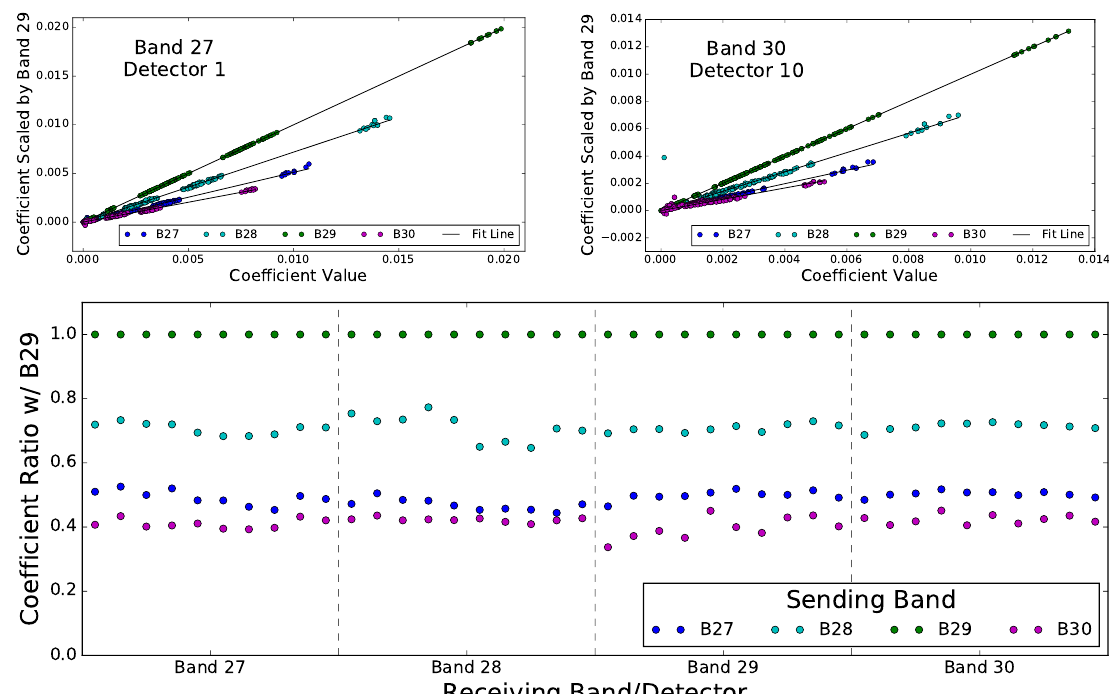
Figure 5. Comparison of the correction coefficient values for each contaminated detector. In the top two figures, the coefficient values ( x -axis) are plotted against the coefficient values squared divided by the band 29 sending coefficient ( y -axis). Here, the slope of the fitted line represents the relative magnitude of the coefficient compared to the band 29 sending coefficient for the entire dataset. In the lower figure, we plot this relative magnitude for each band/detector in the LWIR PV bands. By definition, the band 29 coefficient ratio is equal to